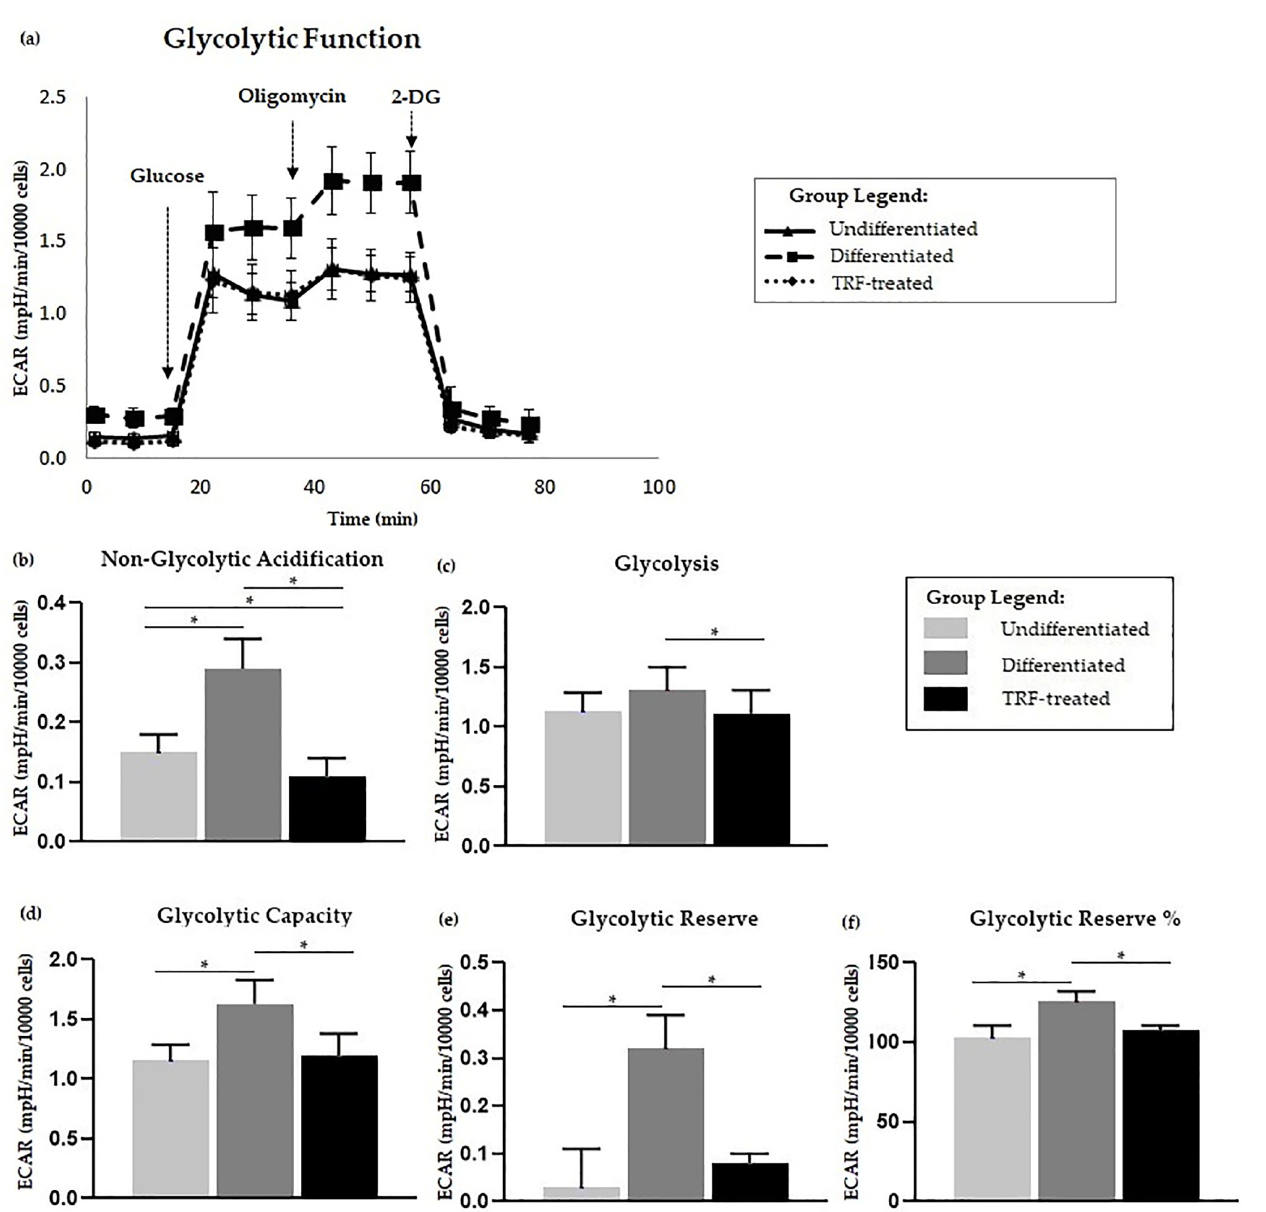
Figure 4. Glycolysis stress assay. Polyethylene-induced differentiation and TRF upon glycolysis stress assay. ( a ) Extracellular acidification rate (ECAR) of overall flux analysis normalized to 10,000 cells. Comparisons between groups in glycolysis stress test parameters; ( b ) non-glycolytic acidification, ( c ) glycolysis, ( d ) glycolytic capacity, as well as ( e ) glycolytic reserve and ( f ) percentage, are shown above. All measured parameters in ( b – f ) were analyzed using one-way ANOVA followed by Tukey’s multiple comparison test. * indicates p <